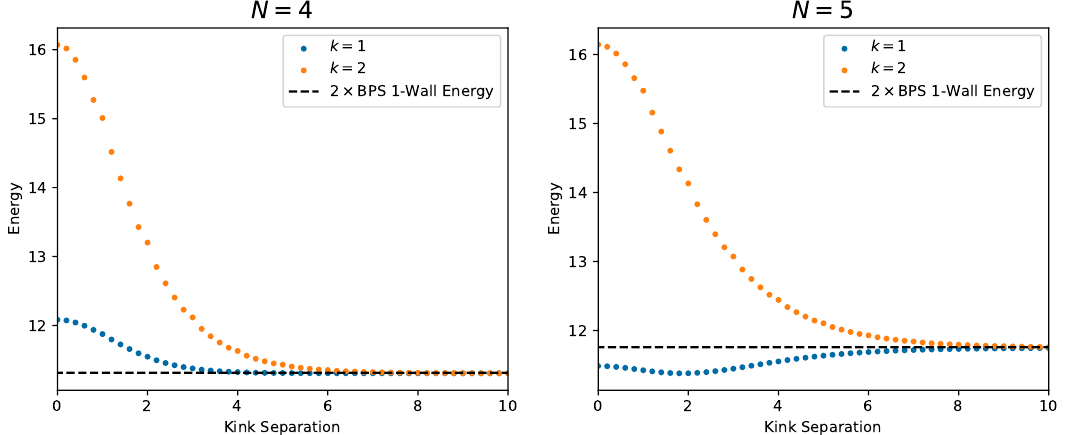
Figure 17. Total energy of the sum of two BPS 1-walls as a function of kink separation. Energies are depicted for N = 4 , 5 and N -alities k = 1 , 2 . Twice the energy of a BPS 1-wall, as given by the dimensionless form of (2.15), is also marked by a dashed line. At large kink separations, the energy of the summed configuration approaches twice the BPS 1-wall energy asymptotically. At small kink separations, we can see from the slope of the energy curves that DWs of N -ality k = 2 tend to repel, whereas DWs of N -ality k = 1 are either only weakly repulsive in the case of N = 4 , or slightly attractive in the case of N = 5 . Note that these results hold for larger and smaller studied gauge groups: N -ality k = 1 continues to be attractive for N > 5 and repulsive for N < 4 , whereas all other N -alities are repulsive for all N